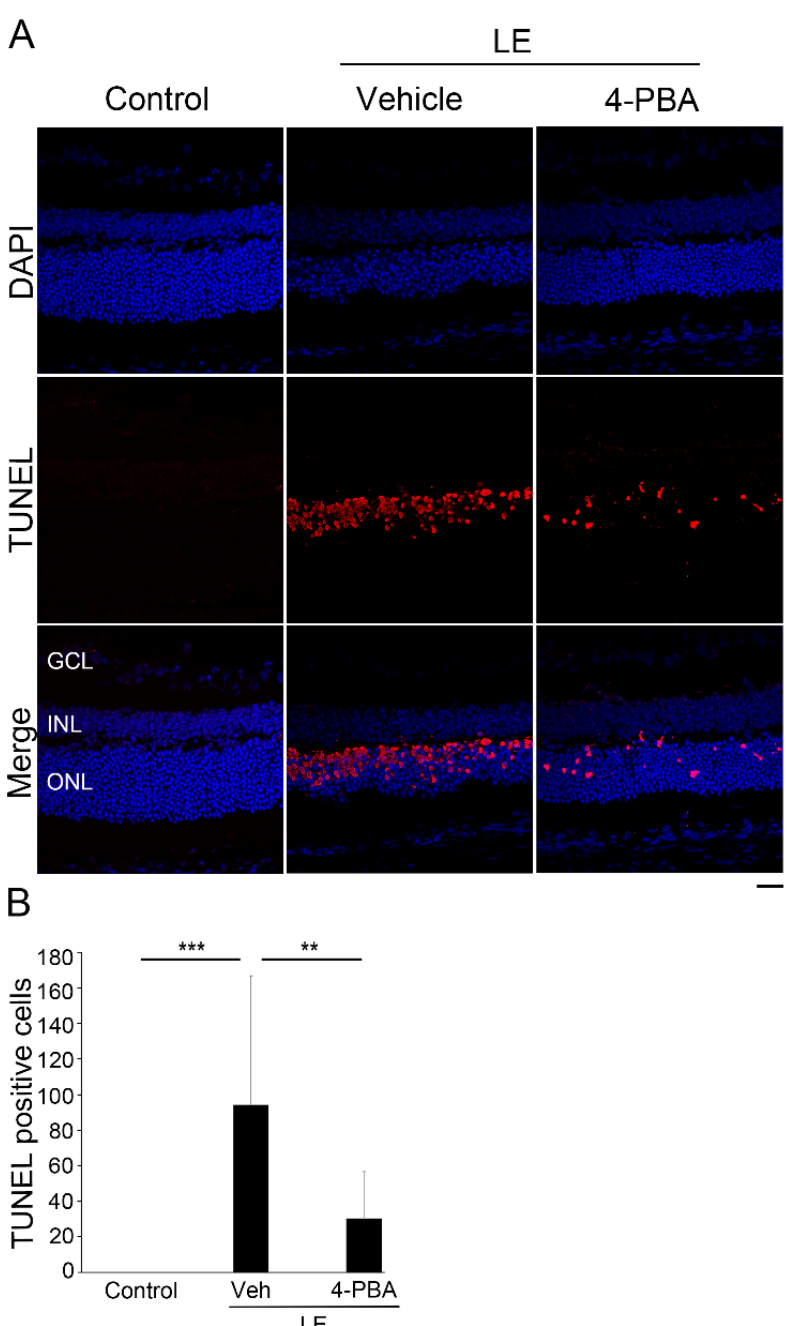
Figure 3. 4-PBA attenuated photoreceptor death after light exposure. ( A ) Representative images of the TUNEL assay 2 days after light exposure with or without 4-PBA treatment. Apoptotic cells (red) were only observed in the ONL, i.e., the photoreceptor cell layer. Nuclei were counter-stained with DAPI (blue). ( B ) Number of Terminal Deoxynucleotidyl Transferase2´-Deoxyuridine, 5´-Triphosphate (dUTP) Nick End Labeling (TUNEL)-positive cells in a section, indicating that 4-PBA attenuated apoptotic cell death; there was no significant difference between control and LE-with-4-PBA-treatment groups ( p = 0.25). LE, light exposure; Veh, vehicle; GCL, ganglion cell layer; INL, inner nuclear layer; ONL, outer nuclear layer. Data are presented as mean ± standard deviation. Control: n = 12, LE with vehicle: n = 12 and LE with 4-PBA: n = 11. Scale bar, 25 μ m. ** p < 0.01, *** p < 0.001. ANOVA with Tukey post-hoc